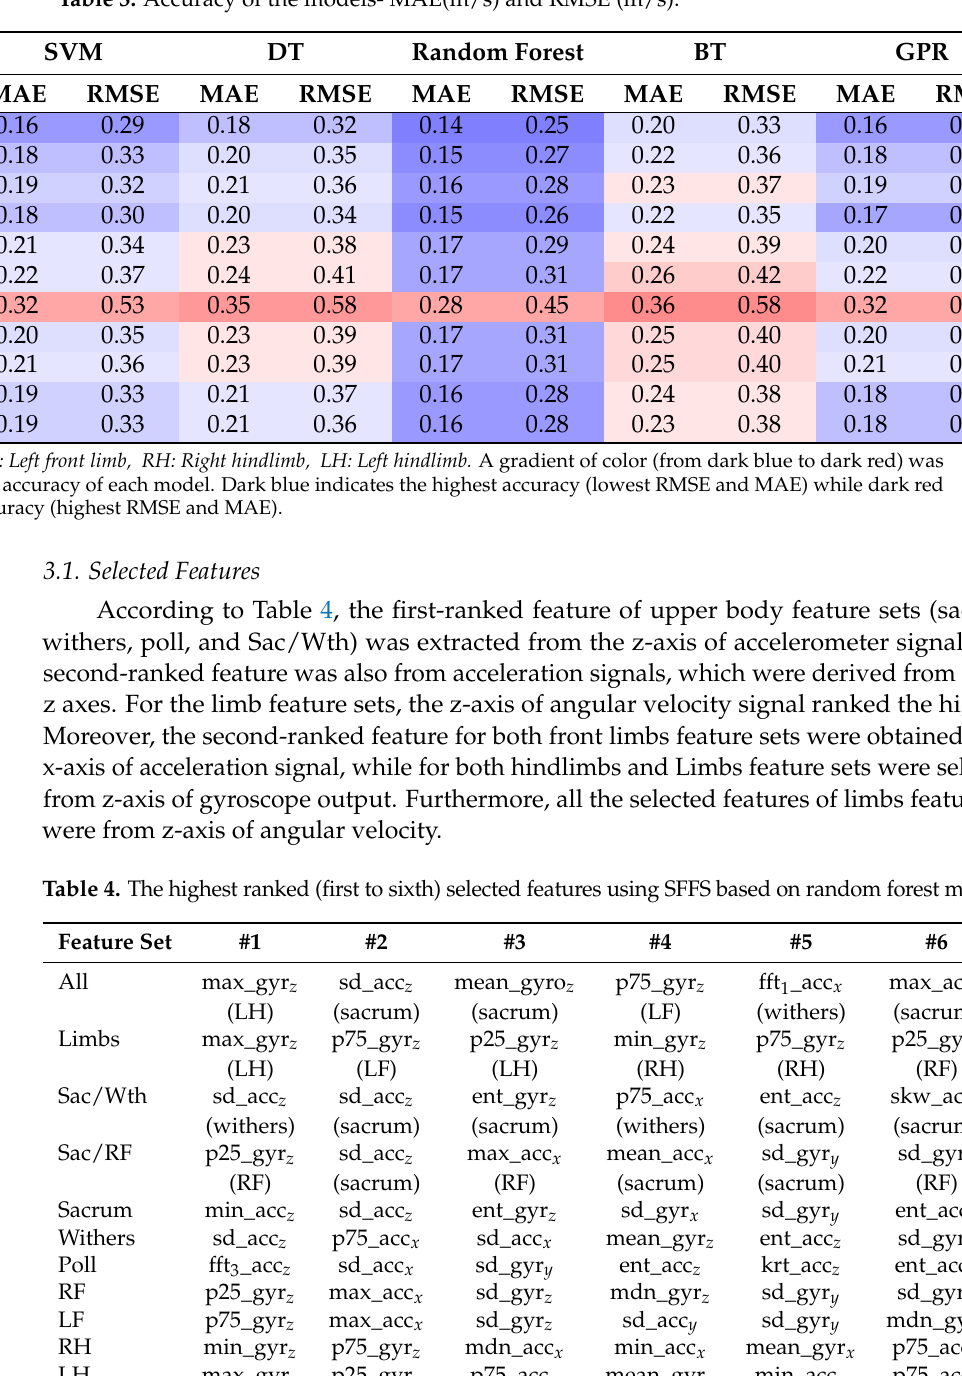
RF: Right front limb, LF: Left front limb, RH: Right hindlimb, LH: Left hindlimb; gyr x , y , z : x, y, and z axis of angular velocity